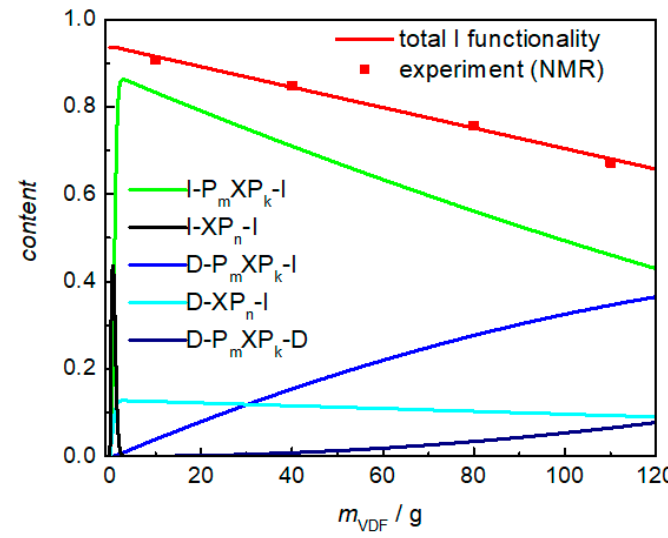
Figure 5. Evolution of the indicated polymeric iodine containing species during the VDF emulsion polymerization. In addition, non ‐ functionalized species D–P m –R–P k –D are contained (sample 2).